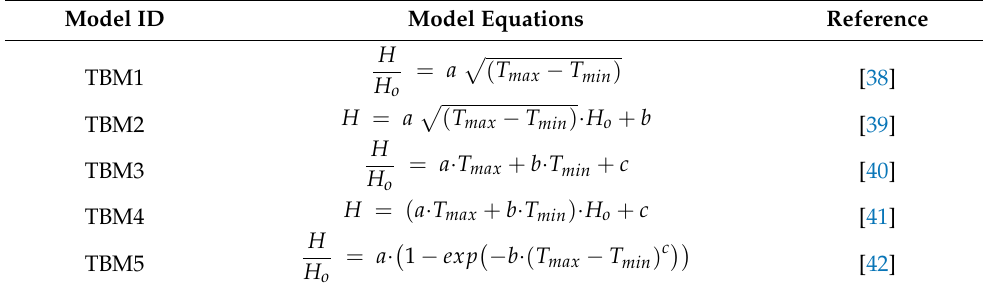
Table 6. Temperature-based models used in this